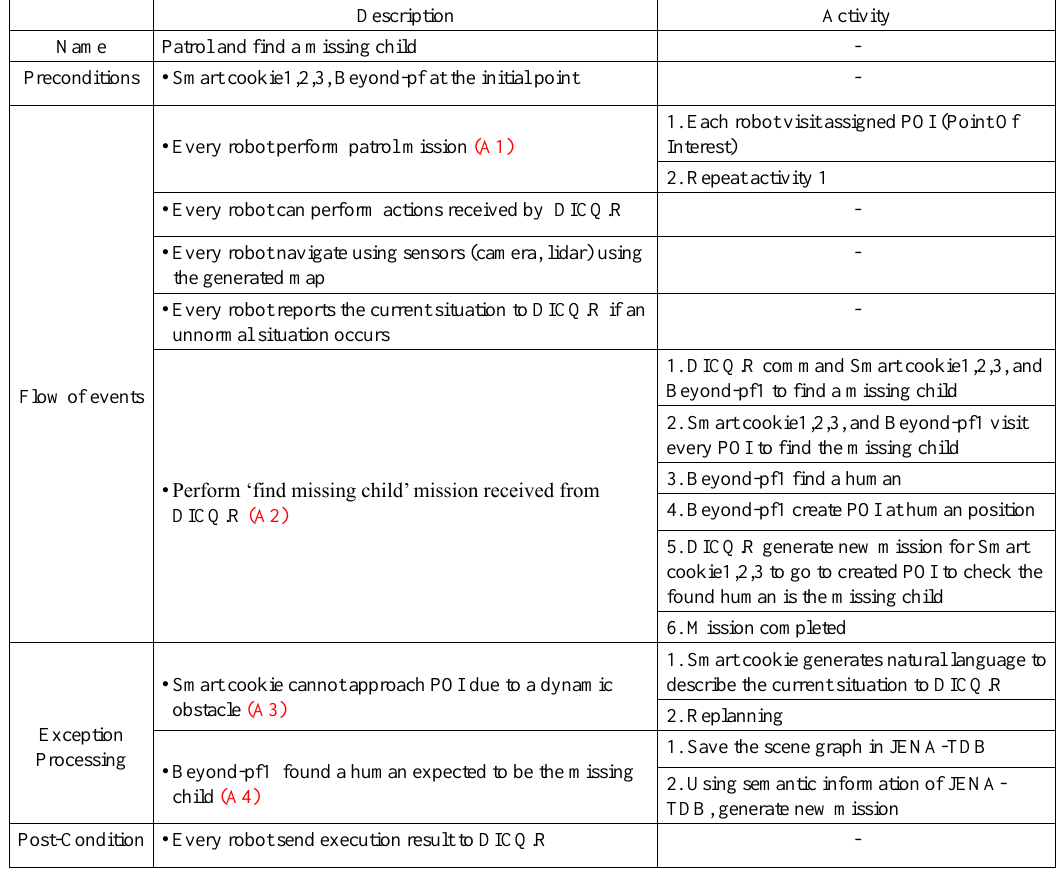
Figure 7. Overall scenario outline: Using one UAV and three AGVs, patrolling was conducted and the missing child was